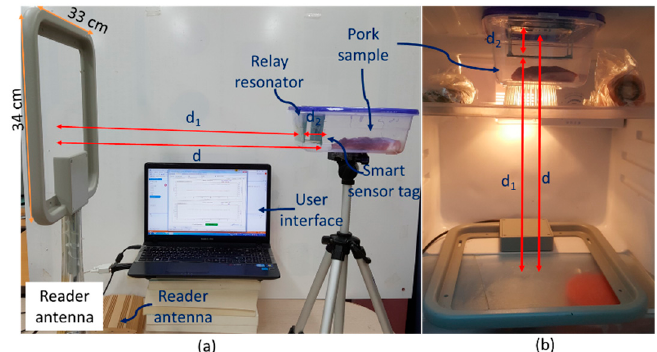
Figure 9. Experimental setup for proposed meat freshness monitoring using relay resonator at ( a ) room temperature and ( b ) refrigerator environments.